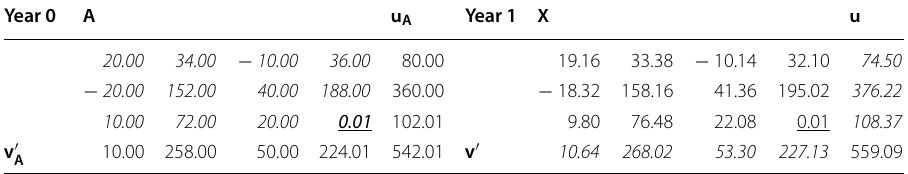
Table 18 Initial matrix with one small entry and the target marginal totals